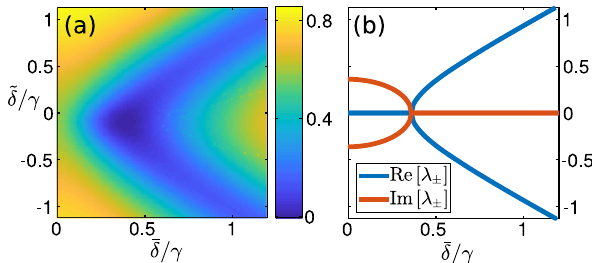
Figure 4: Emergence of CPA due to PT symmetry breaking. ⃒⃒⃒⃒ (a) Intensity t + r | 2 of total coherent outgoing light for symmetric incident light showing the emergence of two real detunings corresponding to CPA. (b) Real part (blue) and imaginary part (orange) of eigenvalues of matrix H T in Equation (22) (in units of γ ), − υ ′ ) (cid:1) υ ′ (cid:1) 0 . 4 γ , with real showing bifurcation at the EP δ (cid:1) ( 2 υ c I P I eigenvalues corresponding to CPA phase shown